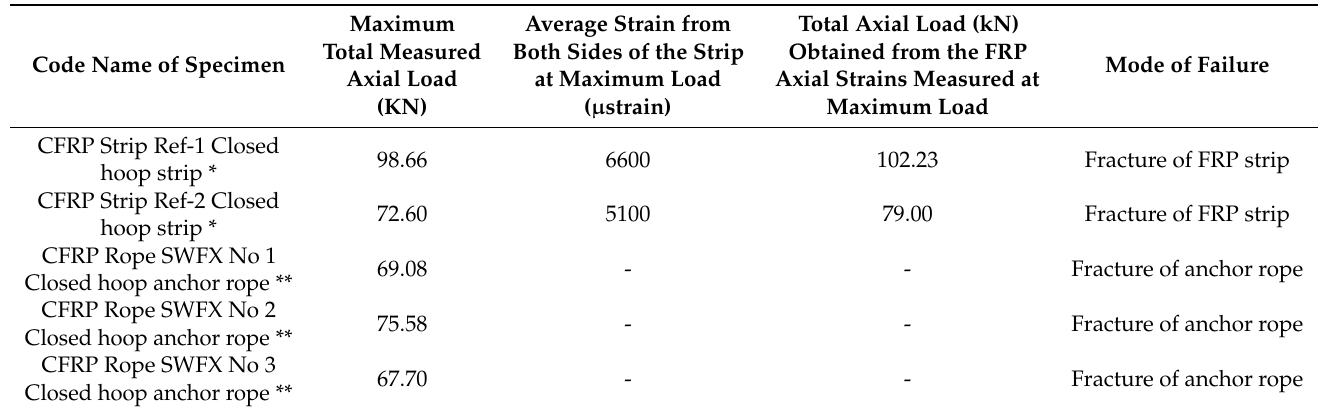
Table 4. Measured tensile capacity of either closed hoop CFRP or closed hoop CFRP anchor ropes (Figure 14a,d).